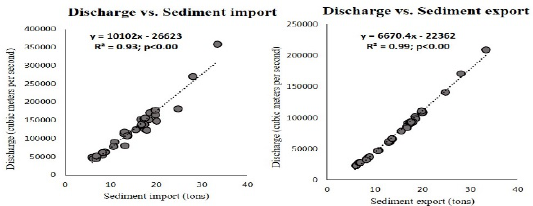
Figure 6. Relationship between river discharge and sedimentation process